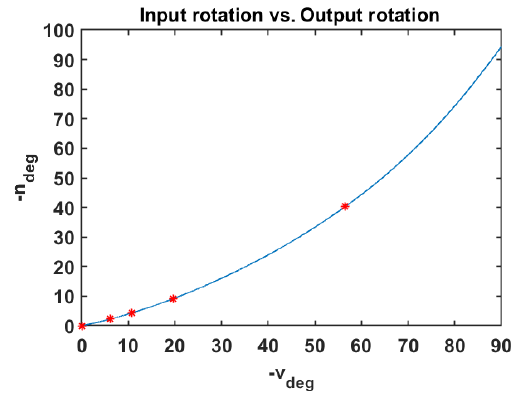
Figure 7. The relationship between input rotation and output rota- tion in degree.